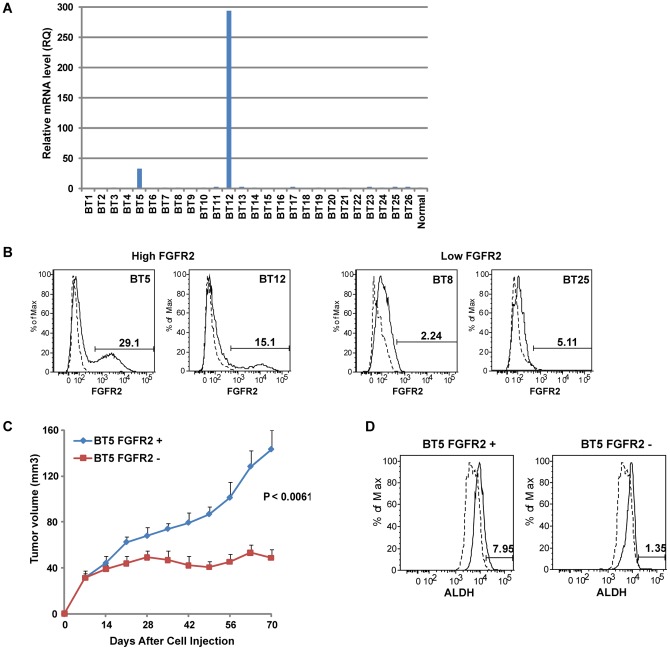
Human Breast TICs Were Enriched in FGFR2+ Population that Was Sufficient to Initiate Tumor Growth.(A) The expression levels of FGFR2 mRNA in patient-derived breast tumors. Quantitative real-time PCR was performed using cDNA generated from RNA isolated from 26 primary human breast cancer specimens. cDNA isolated from a normal breast tissue was used to normalize data and generate RQ. (B) Flow cytometry analysis of FGFR2 protein expression in primary human breast tumors. High (BT5 and BT12) or low level (BT8 and BT25) of FGFR2 protein corresponded to high or low level of FGFR2 mRNA (A). This figure represents a typical result of three independent experiments. Dashed line shows an unstained control for each tumor sample. (C) Effect of FGFR2 expression on primary human breast tumor growth. FGFR2−overexpressing primary human breast tumor cells (BT5) were FACS sorted based on the expression of FGFR2. The two isolated populations (FGFR+ and FGFR2−) were injected in the mammary fat pad of the NOD/SCID mice (n = 5 per group). P value at day 70 is indicated. Data represent mean ± SEM. (D) Flow cytometry analysis of ALDH activity in FGFR2+ and FGFR2− subpopulations of BT5 tumors. Higher ALDH activity was found in the FGFR2+ population compared to the FGFR2− population. Dashed line shows a specific inhibitor of ALDH (DEAB)-treated labeling.